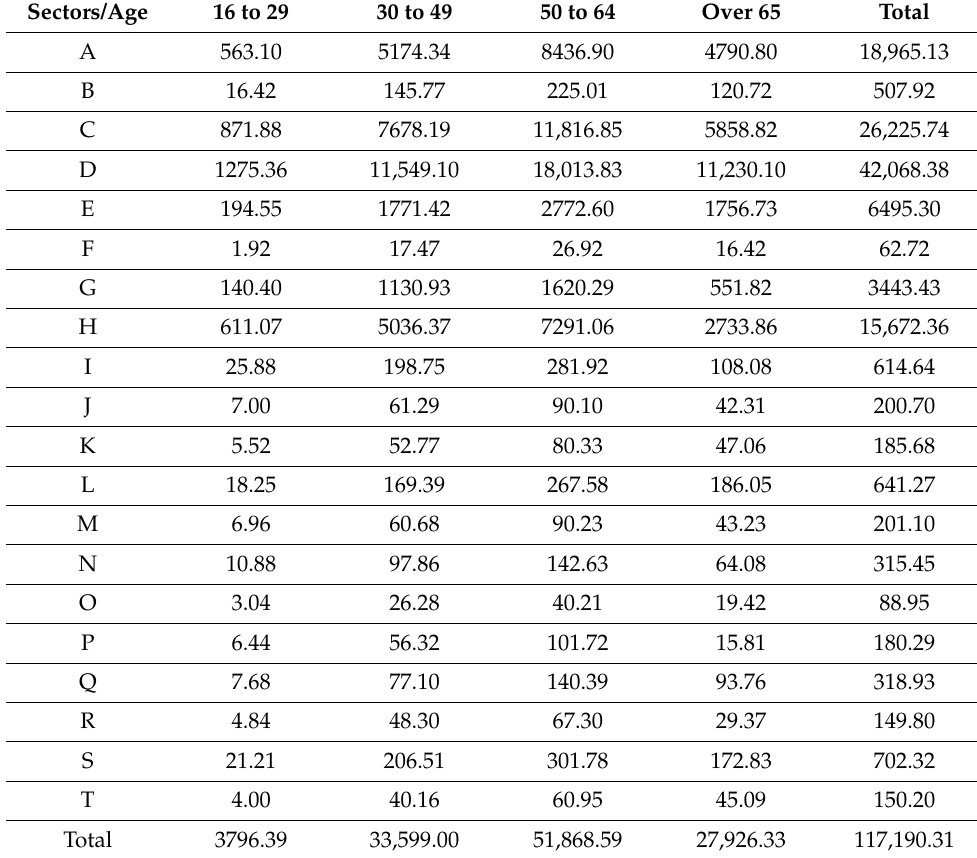
Table A2. CO 2 emissions associated with household consumption by age bracket and productive sector for 2015 (thousands of tons of CO 2